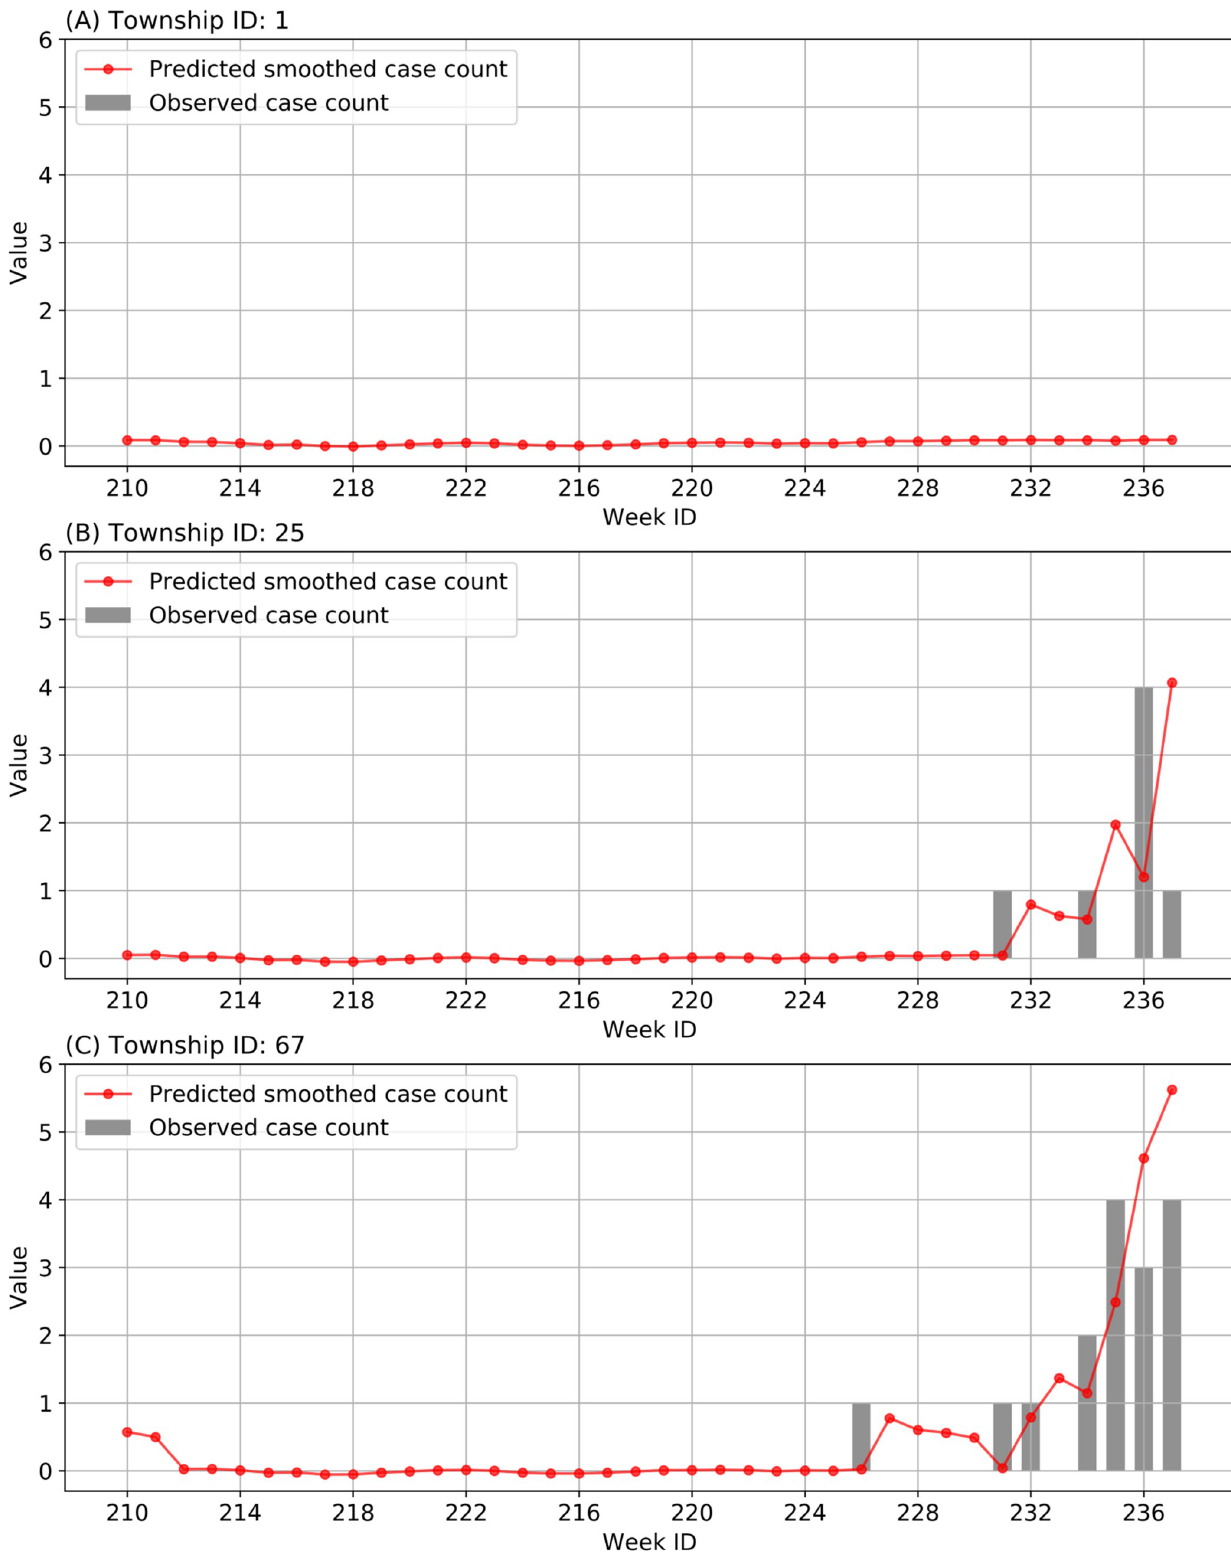
Fig 8. Predicted smoothed case counts and observed case counts of three randomly selected townships in Guangzhou during the validation period. The smoothed case counts were predicted by the 1-week ahead SVM-based model using both common features and interaction features. https://doi.org/10.1371/journal.pntd.0008924.g008 PLOS NeglectedTropical Diseases | https://doi.org/10.1371/journal.pntd.0008924 December21,